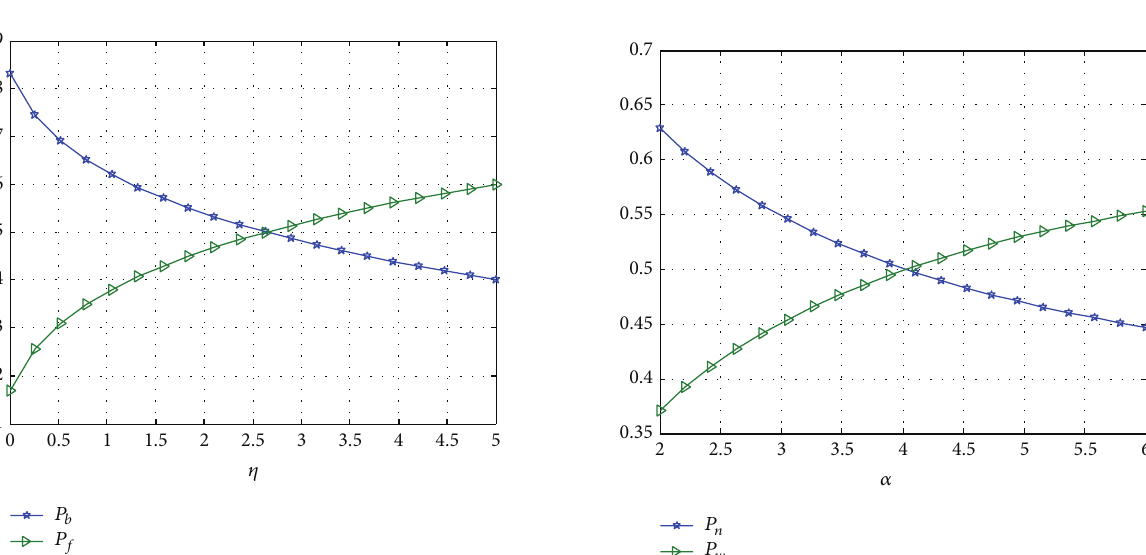
Figure 4: The effect of 𝜂 on 𝐸[𝐿] for two different retrial policies.